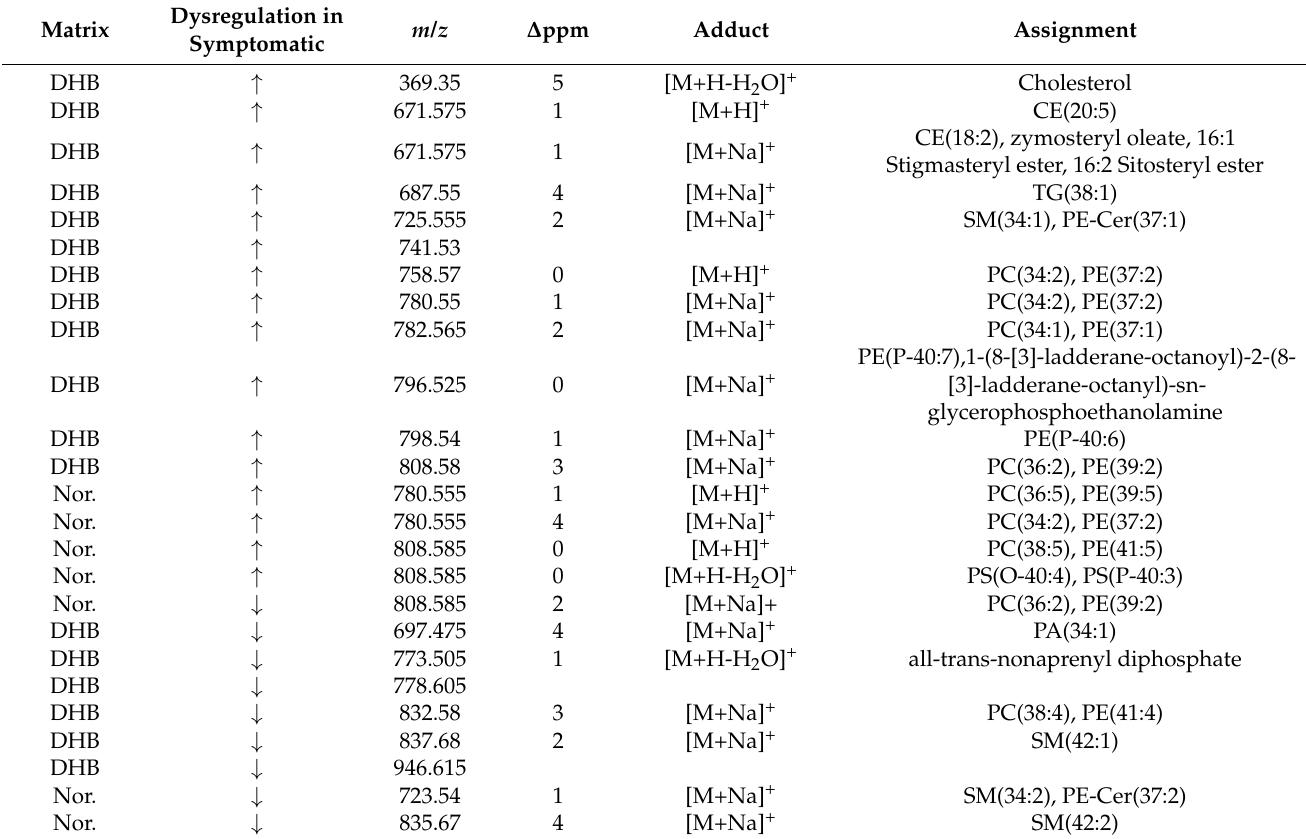
Table 2. Dysregulated lipids in the inner VSMCs region of symptomatic plaques. Species with a VIP score greater than one and with a loading on the first PLS axis exceeding the 90th percentile of the positive or negative values are reported.